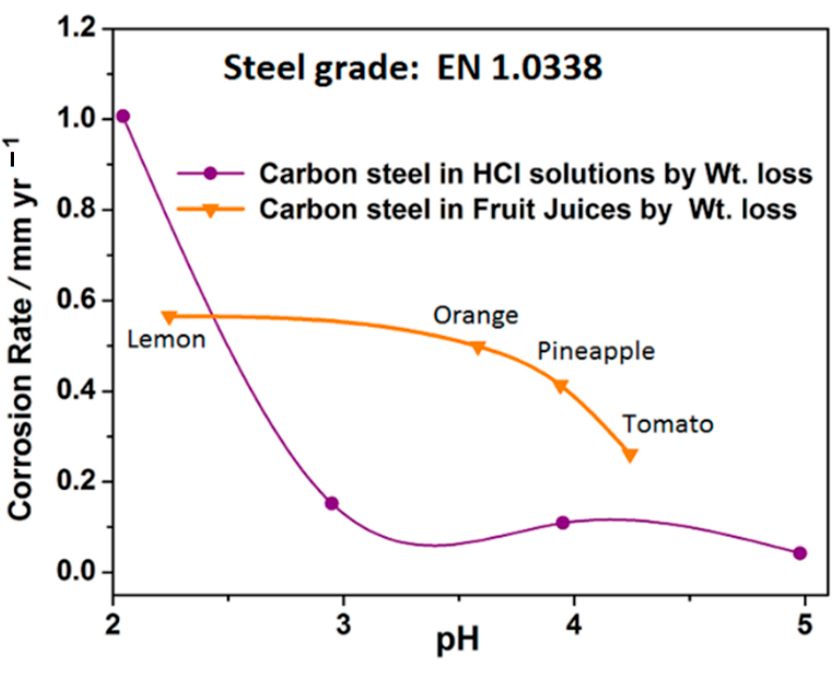
Figure 13. Plot of corrosion rate vs. test media pH for carbon steels after 5 h immersion in fruit juices, and acidic chloride solutions of varying pH evaluated from gravimetric data.